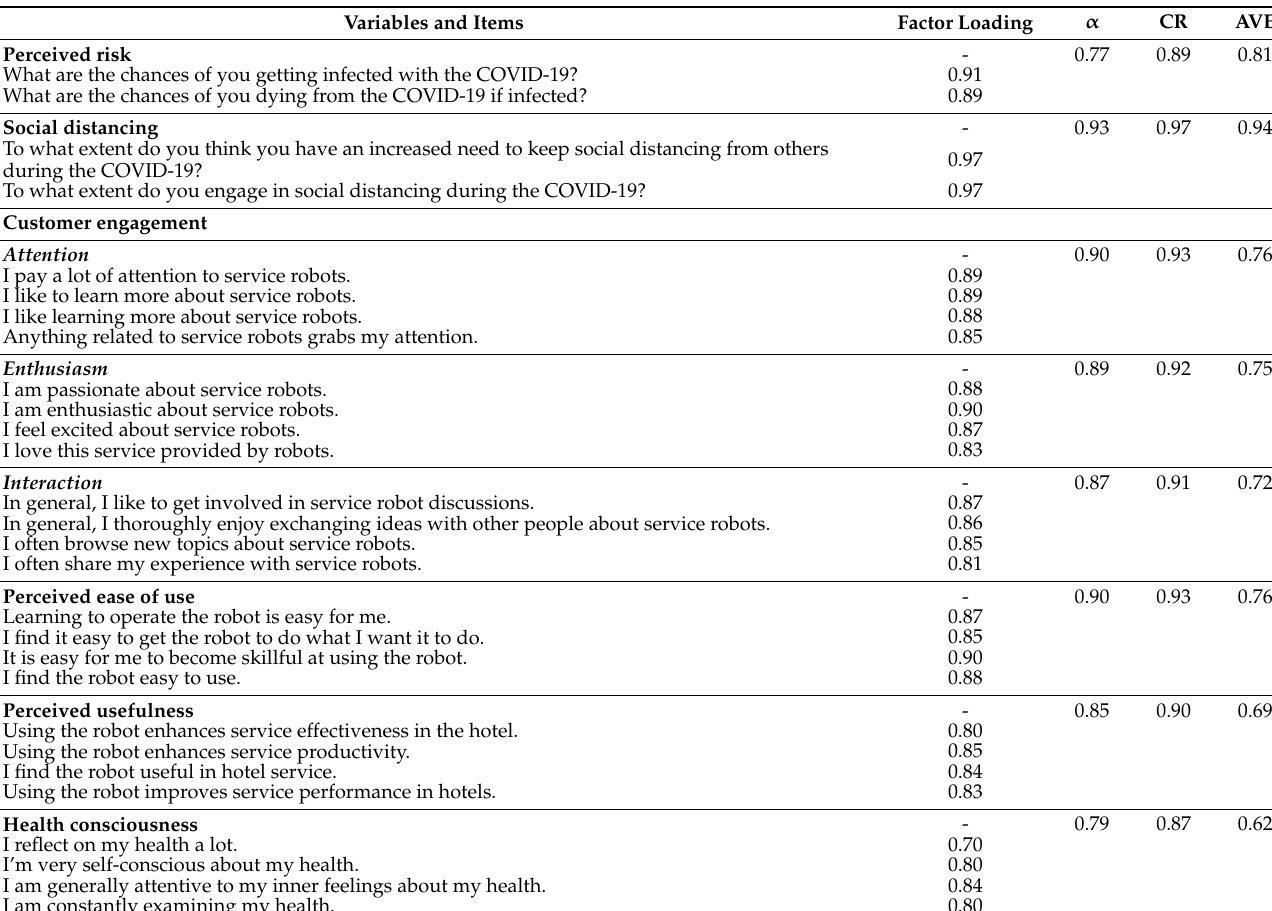
Table 2. Measured items and CFA